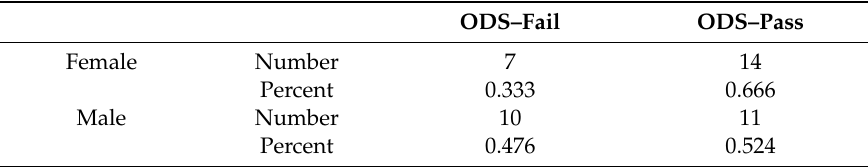
Table 6. Pearson chi-squared analysis for overhead deep squat (ODS) and